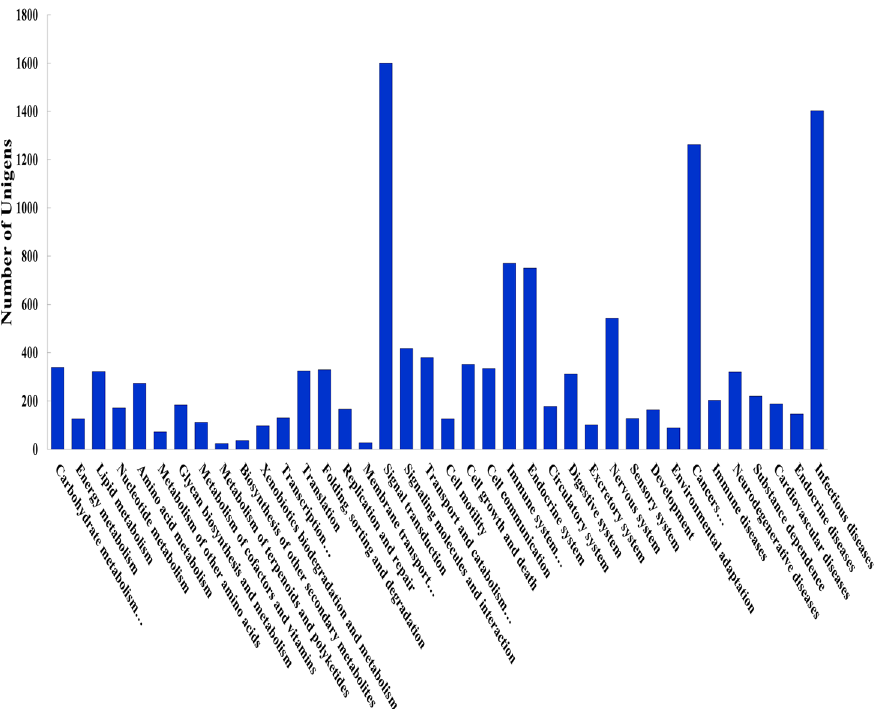
Fig 4. Eukaryotic clusters of orthologous group (KOG) classification. A total of 6088 sequences were clustered into 38 KOG categories.